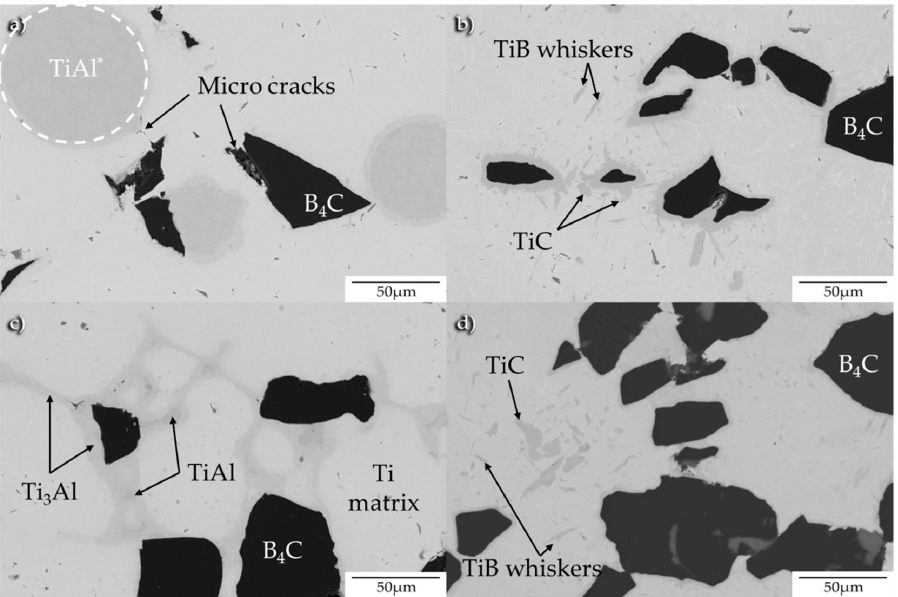
Figure 6. SEM images of the TMCs processed under 40 MPa for 5 min, from the starting materials: ( a ) Ti matrix with TiAl* and B 4 C particles at 1000 °C; ( b ) Ti matrix with TiAl* and B 4 C particles at 1200 °C; ( c ) Ti matrix with Ti-Al and B 4 C particles at 1000 °C; ( d ) Ti matrix with Ti-Al blend and B 4 C particles at 1000 °C. Metals 2018 , 8 , x FOR PEER REVIEW